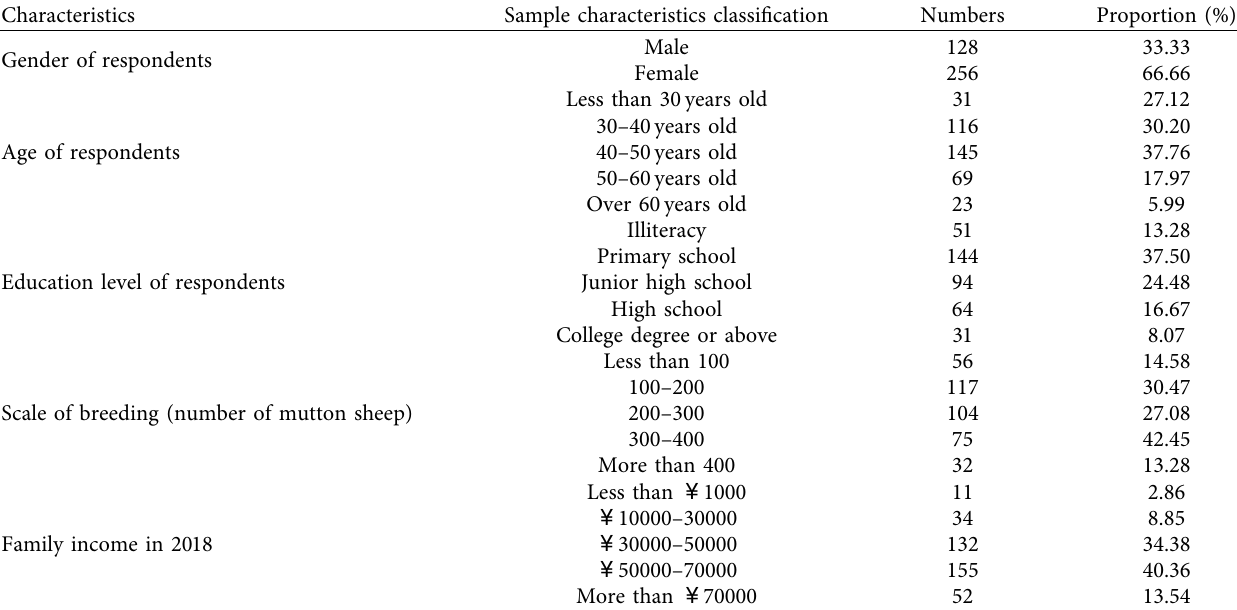
Table 2: Basic characteristics of samples.